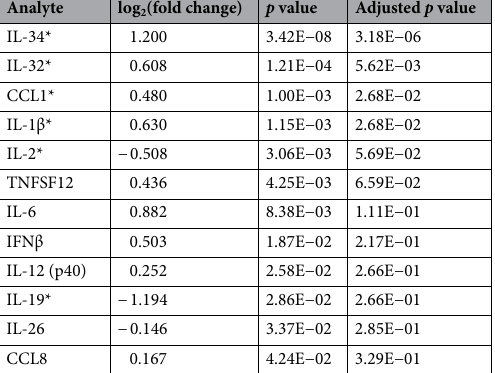
Analyte log 2 (fold change) p